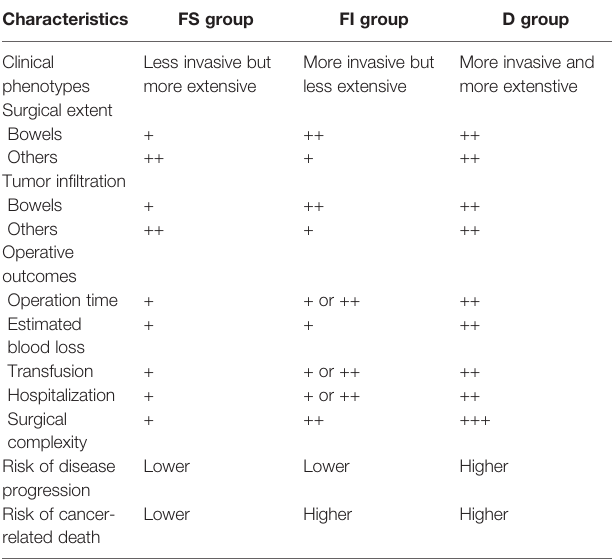
TABLE 5 | Recurrence pattern. TABLE 6 | Clinical phenotypes based on the resection types of tumors involving the rectosigmoid